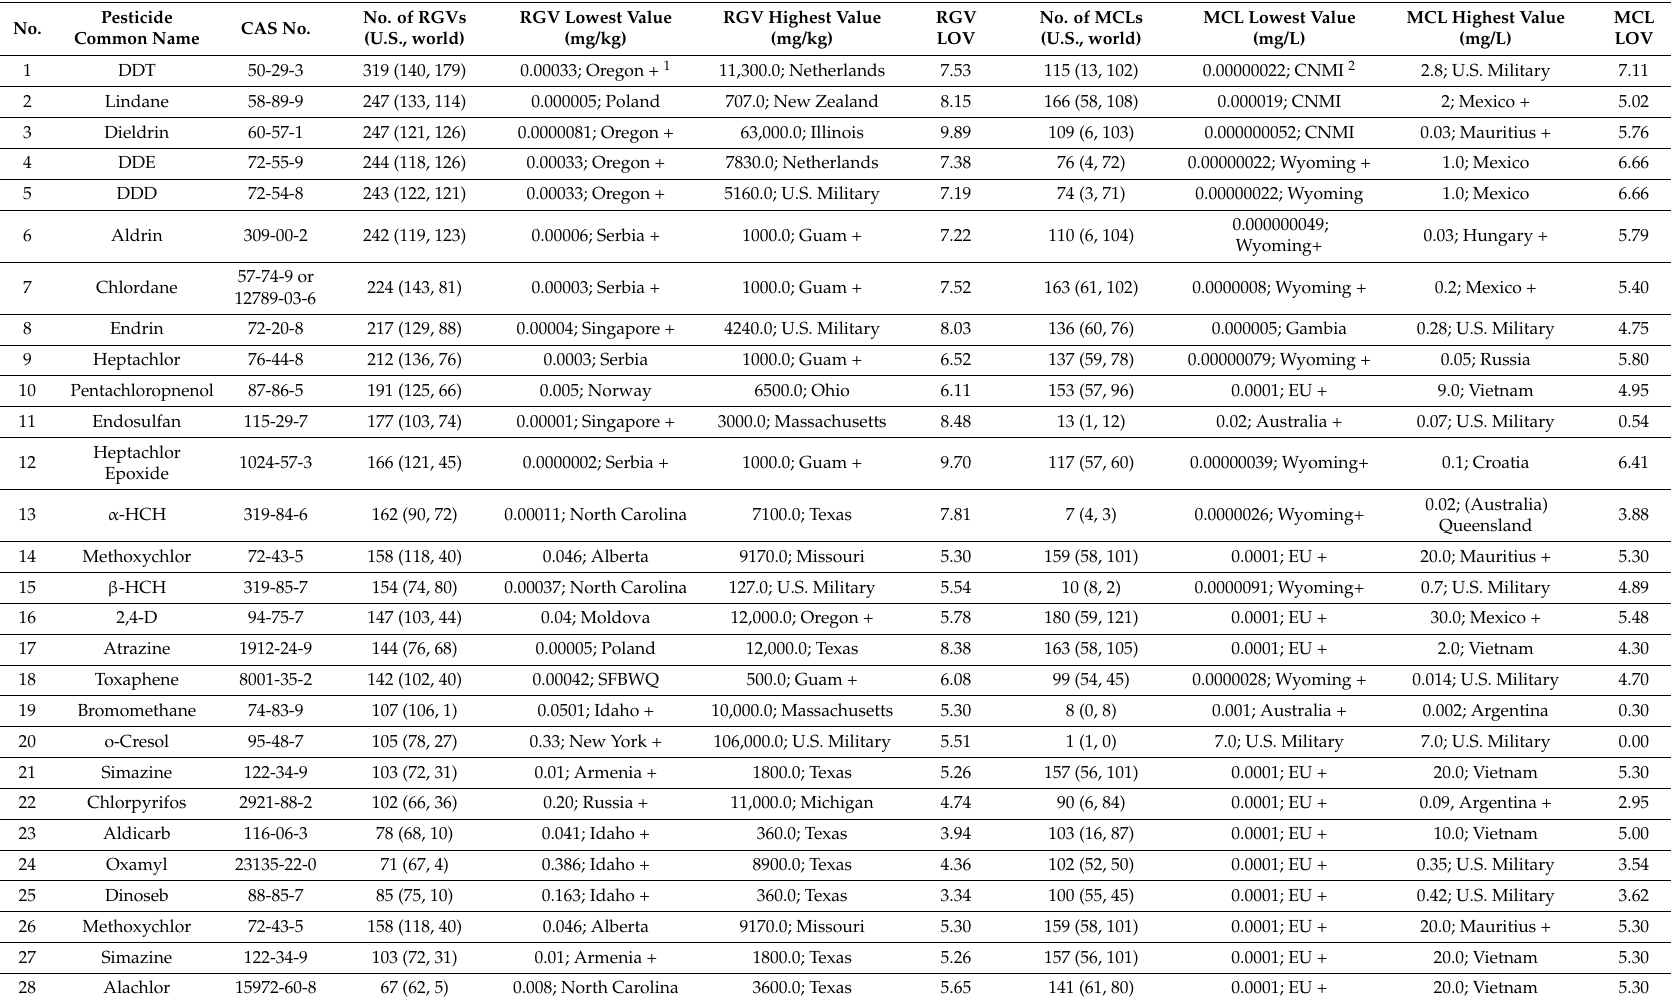
Table 4. Summary of the most commonly regulated pesticides in residential surface soil and drinking